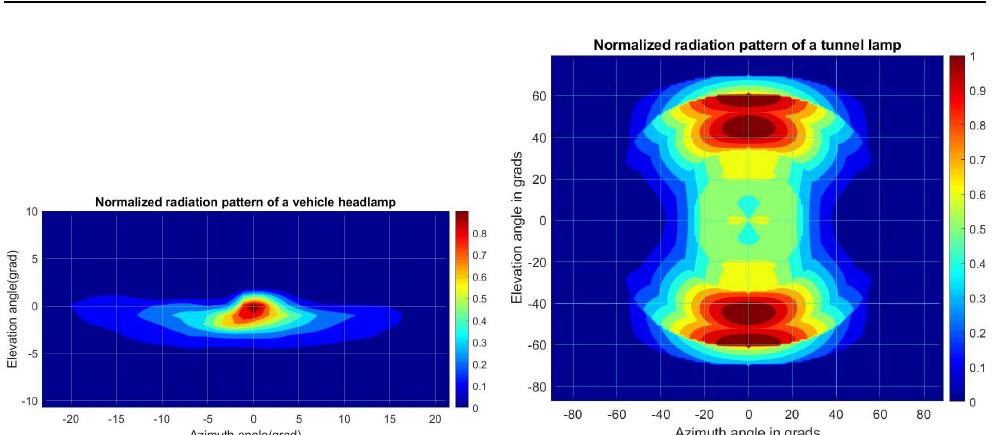
Figure 15. On the left side, the headlamp radiation pattern, and on the right the tunnels lamp radiation